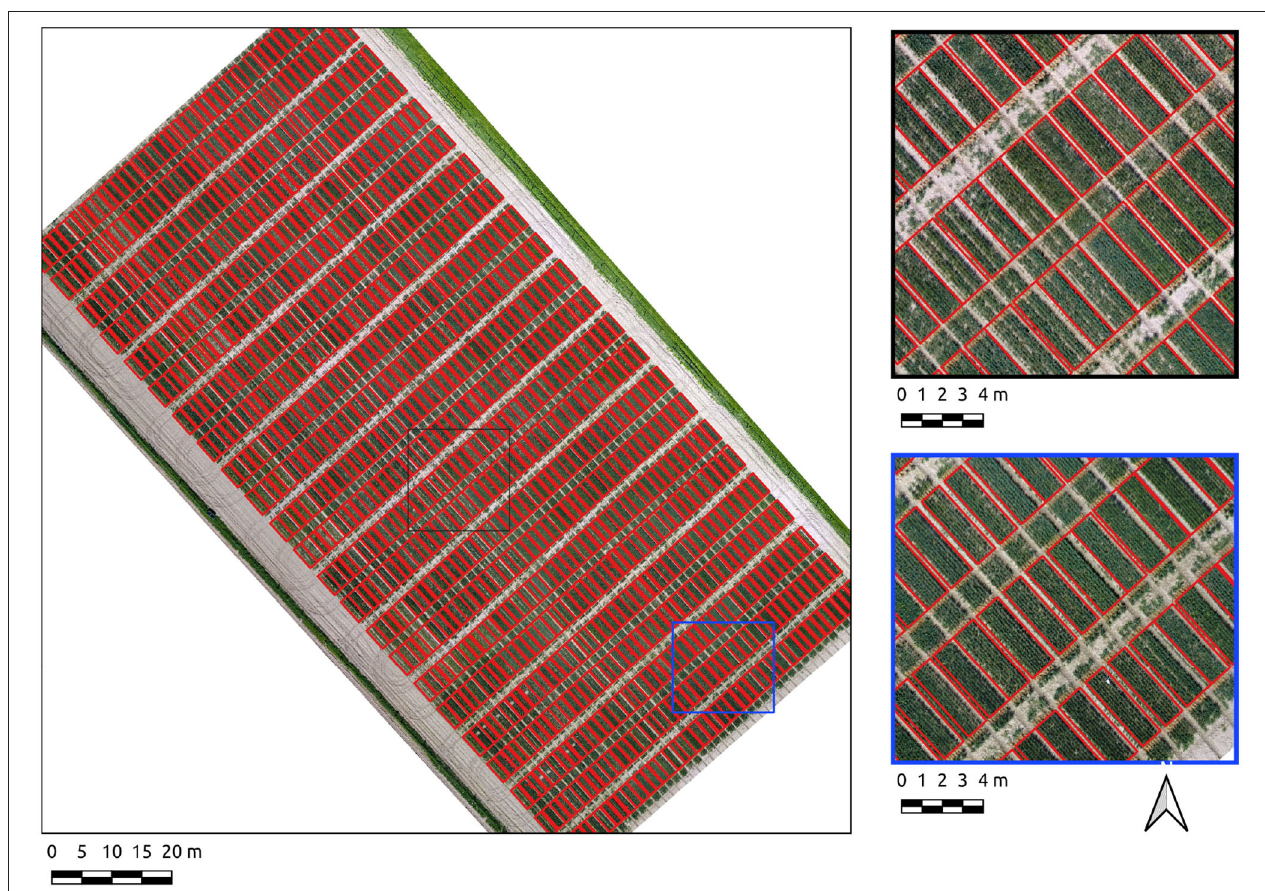
FIGURE 6 | Segmentation results on the Cae Gwyn 8 site crop plots set using the Canny-based approach.